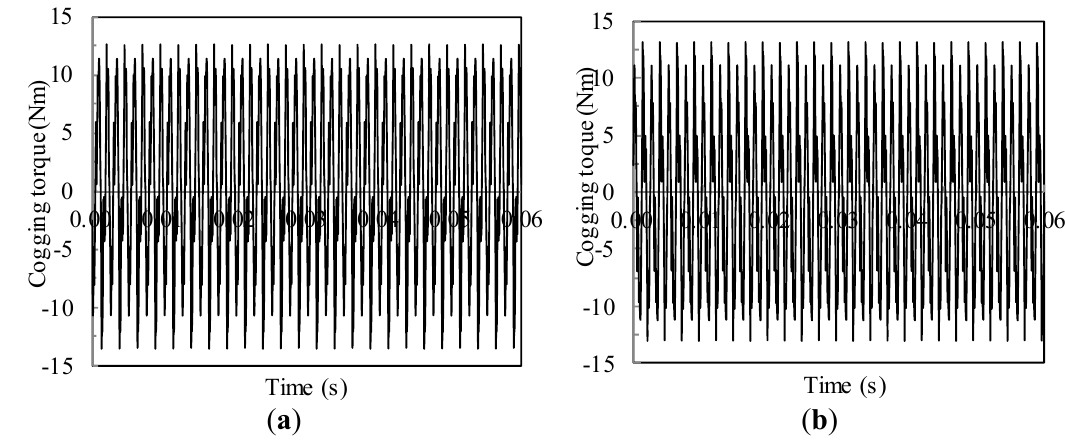
Figure 11. Cogging torque waveforms: ( a ) cogging toque waveform of the permanent magnet rotor; and ( b ) cogging torque waveform of the modulating ring